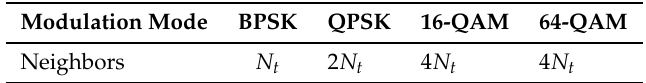
Table 1. The number of nearest neighbors for different modulation modes: BSPK, QPSK, 16-QAM, 64-QAM.